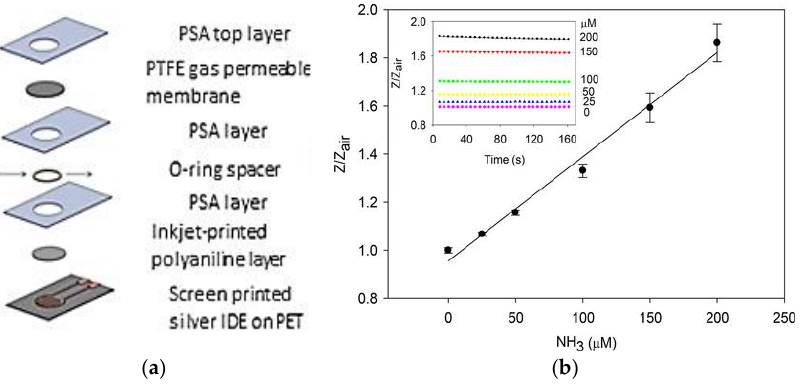
Figure 10. ( a ) Description of devices; ( b ) Calibration curve. Reprinted from